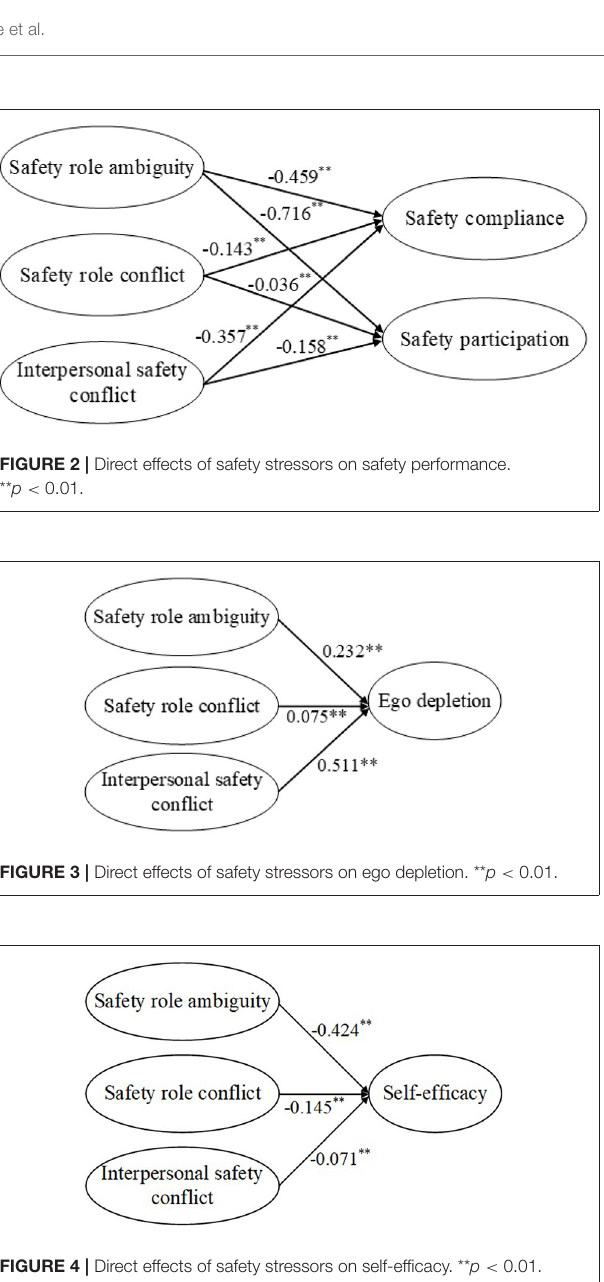
FIGURE 7 | Structural equation model of the conceptual model. * p < 0.05; ** p < 0.01 (two-tailed); N = 335.